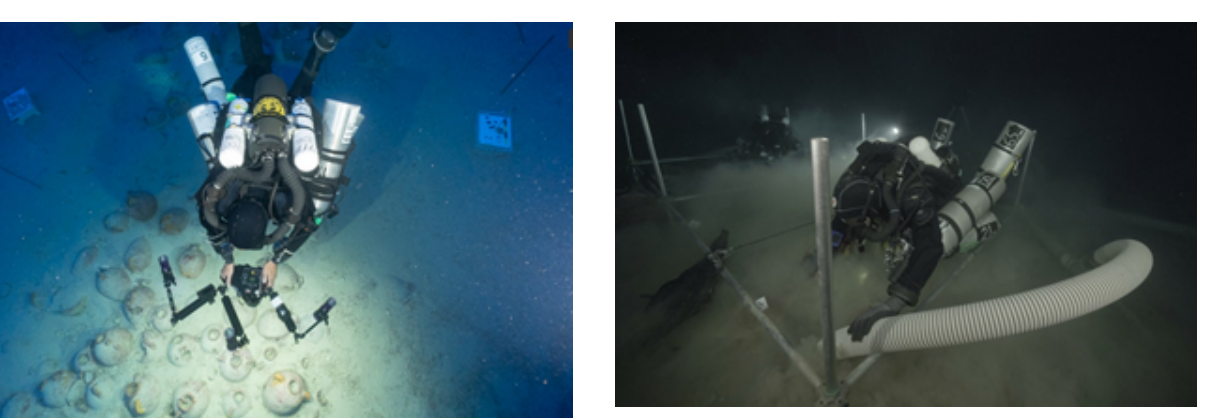
Figure 1. Shooting images: one diver holds the camera and the other two handle the lights. Photo: J. Wood (2018).